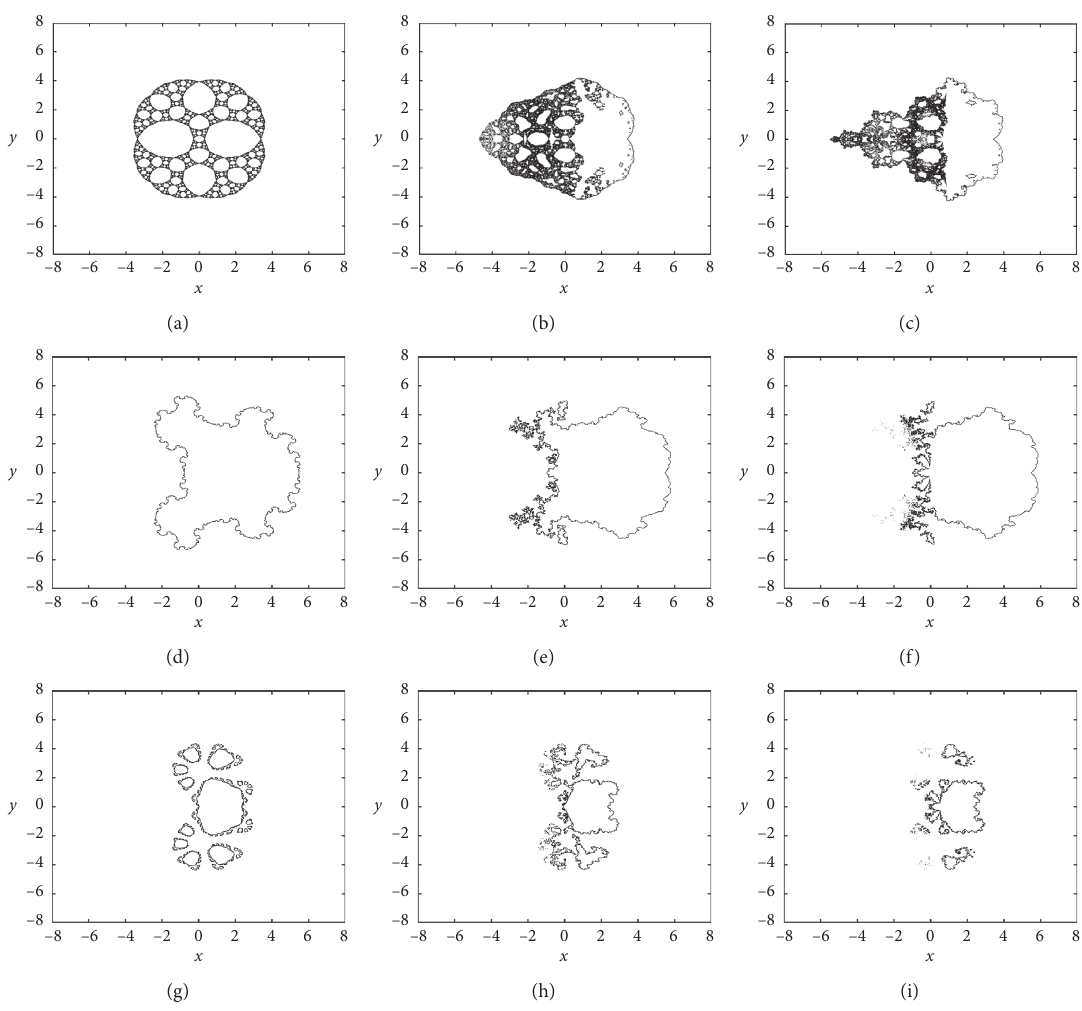
Figure 1: Julia sets of the discrete fractional system (15) with different values of orders ] and parameters μ and p . (a) ] � 1, μ � 2, p � 2; (b) ] � 0 . 6, μ � 2, p � 2; (c) ] � 0 . 3, μ � 2, p � 2; (d) ] � 1, μ � 6, p � 2; (e) ] � 0 . 45, μ � 6, p � 2; (f) ] � 0 . 3, μ � 6, p � 2; (g) ] � 1, μ � 7, p � 5; (h) ] � 0 . 6, μ � 7, p � 5; (i) ] � 0 . 3, μ � 7, p �